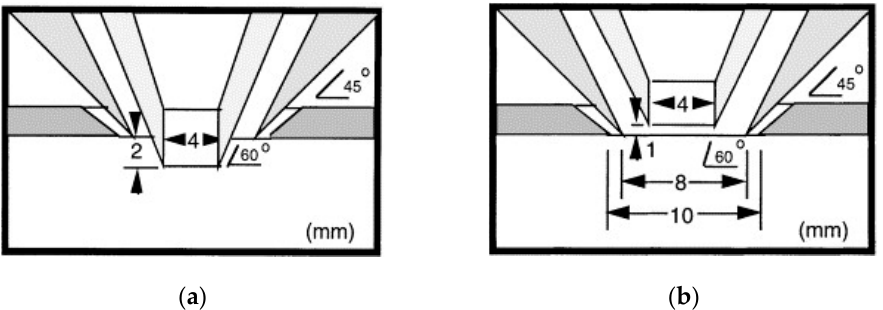
Figure 8. Coaxial deposition head configurations: ( a ) outward and ( b ) inward nozzle position (reproduced with permission from [60]; Copyright © 2000 Elsevier).